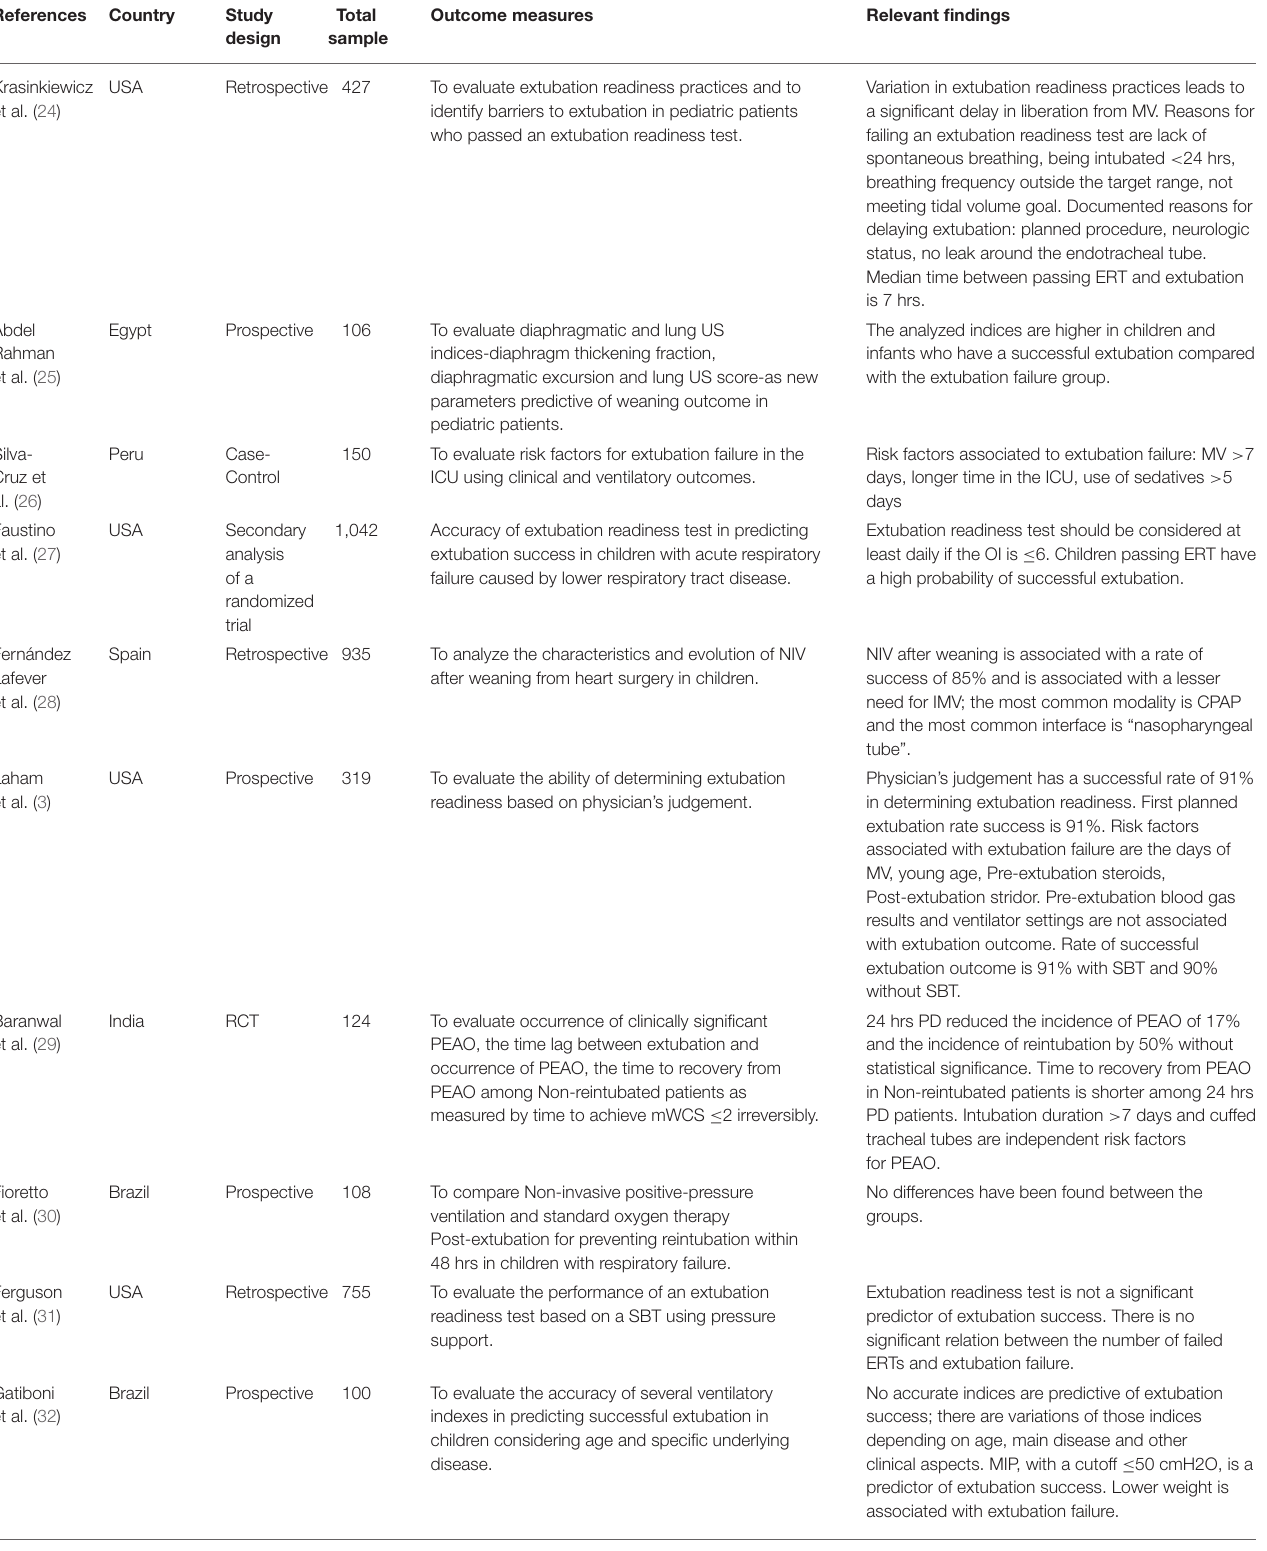
TABLE 2 | Extubation readiness/failure: summary of the reviewed